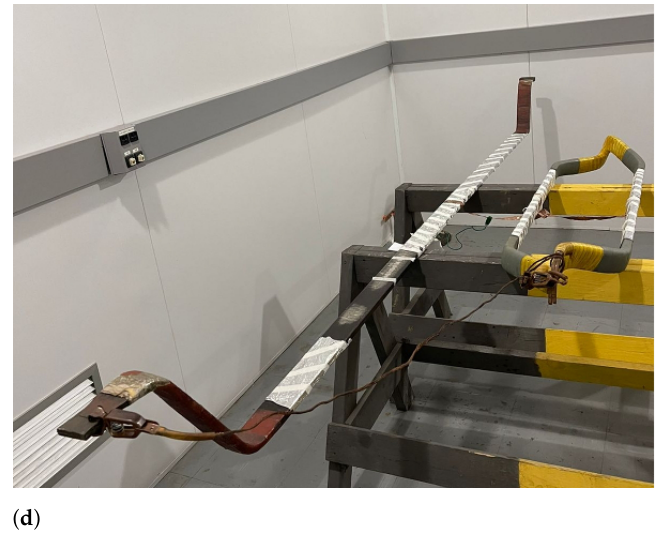
Figure 12. The measurement setup: ( a ) overview of the measurement setup for acquiring high frequency PD radiated signals, ( b ) General Electric bar from Curuá-Una hydroelectric power plant (with corona PDs), ( c ) Jeumont-Schneider bar from Tucuruí hydroelectric power plant (with slot PDs), and ( d ) parallel-connected bars for producing concurrent corona and slot